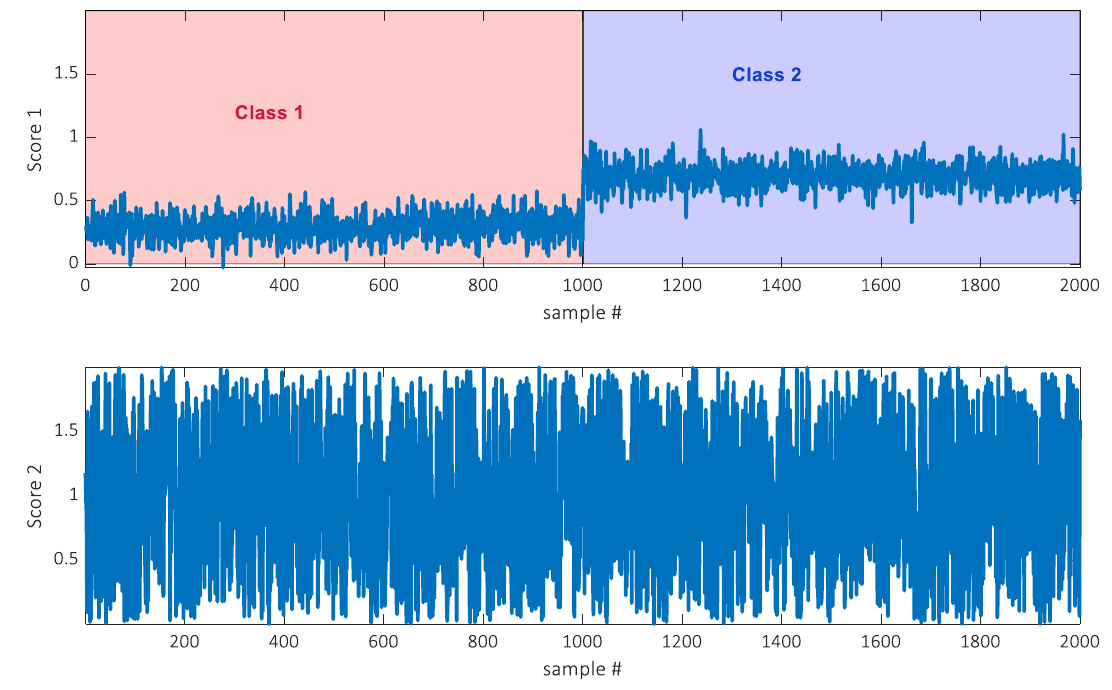
Figure 1. Two scores of two thousand samples from the simulated dataset. Score one indicates the class belongingness.